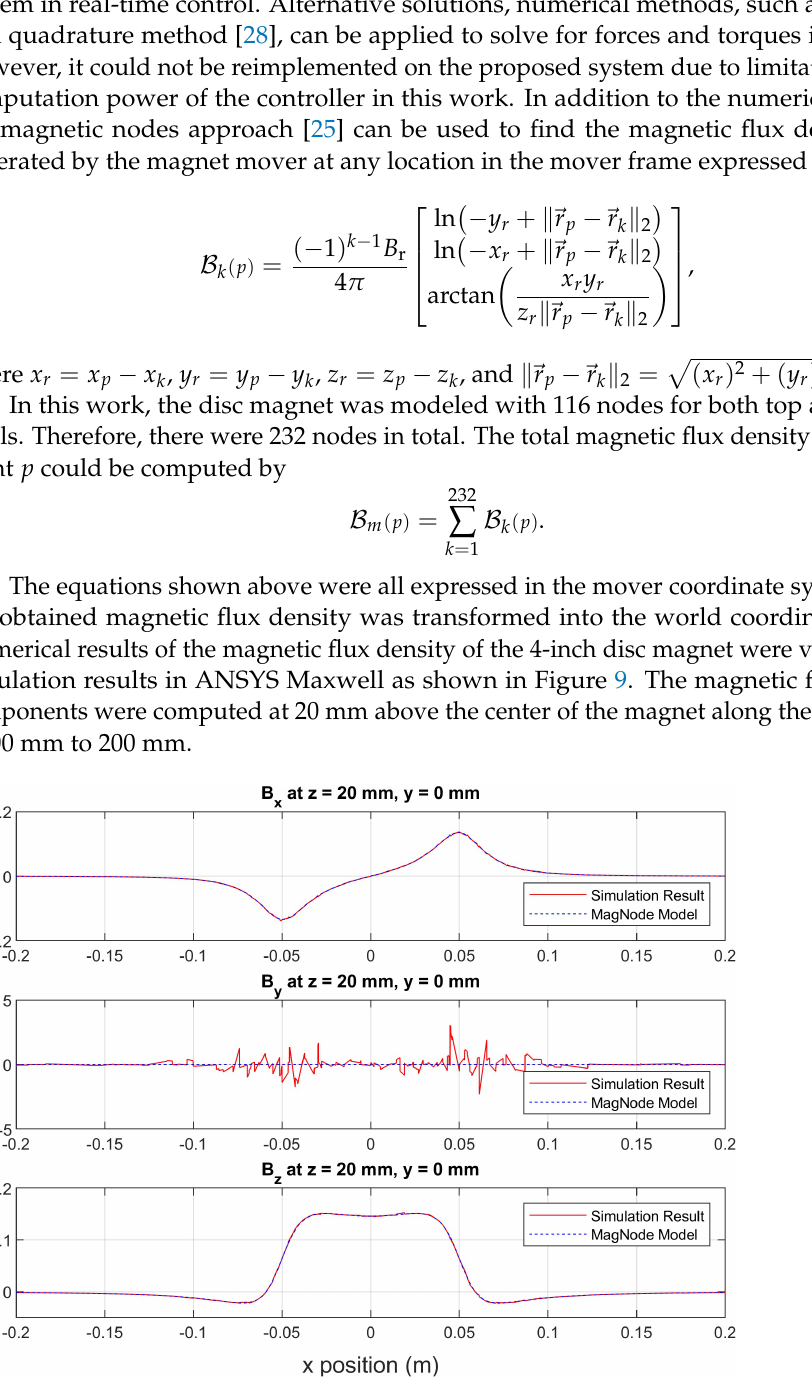
Figure 9. Magnetic field verification of disc magnet